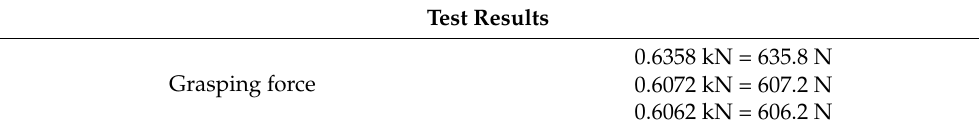
Figure 26. Test of grasping force. Table 2. Test value of grasping force.